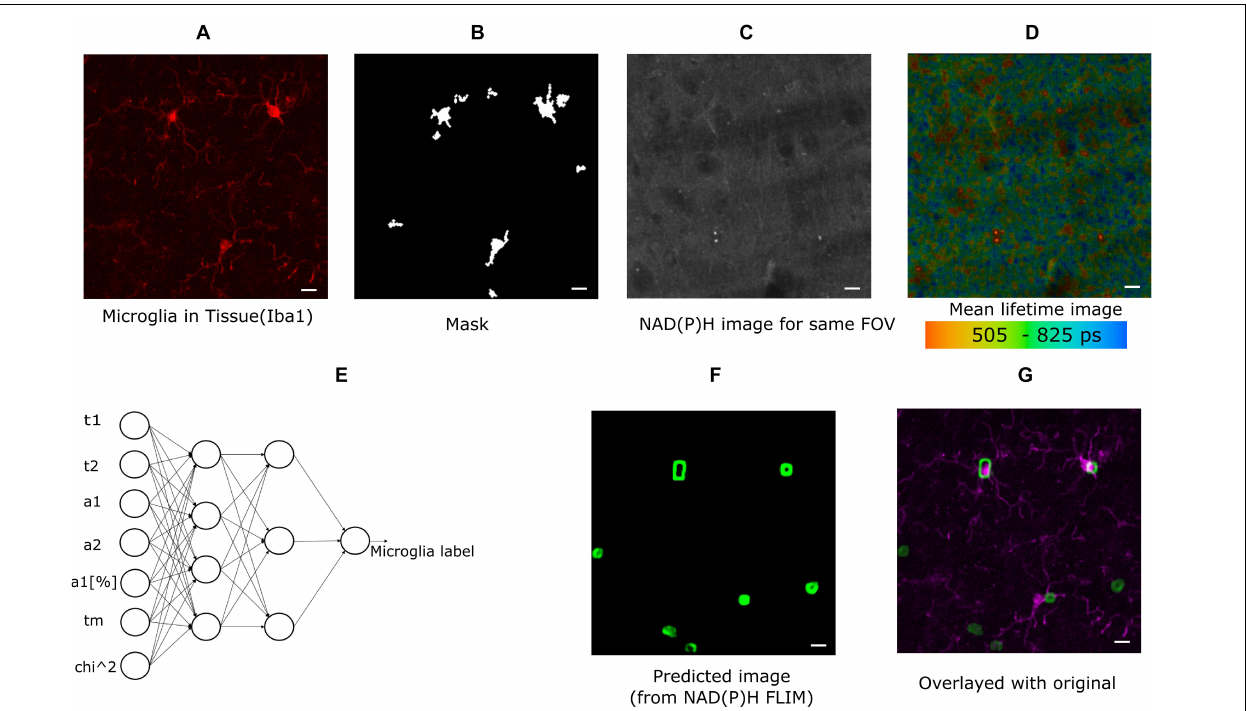
FIGURE 1 | Method demonstrating microglia prediction using ANN. (A) Microglia image using Iba1. (B) Mask created from Iba1 image (C) NAD(P)H intensity image from the same FOV. (D) Lifetime image of the same FOV created from SPCImage (Becker and Hickl GmbH, Berlin, Germany) (E) ANN showing the inputs used for training instances and output (F) predicted microglia image. (G) Composite image showing fusion of predicted microglia image and actual microglia image created from Iba1 (scale bar 10 µ m, A–D,E,F